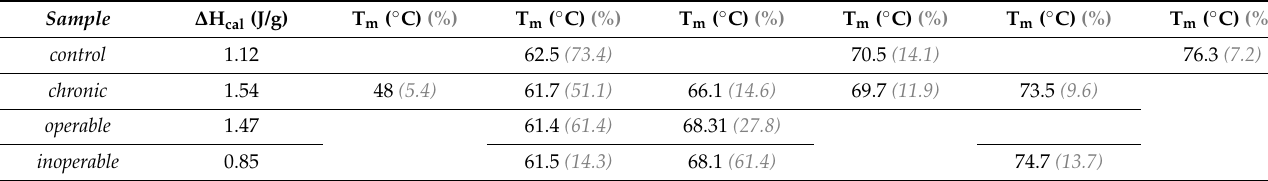
Table 5. Contribution of deconvolved transitions from Figure 3 to the total enthalpy change, gray numbers represent the relative participation to the total change (based on instrument error, only those compounds are used which have a higher than 5% change, recently evaluated).